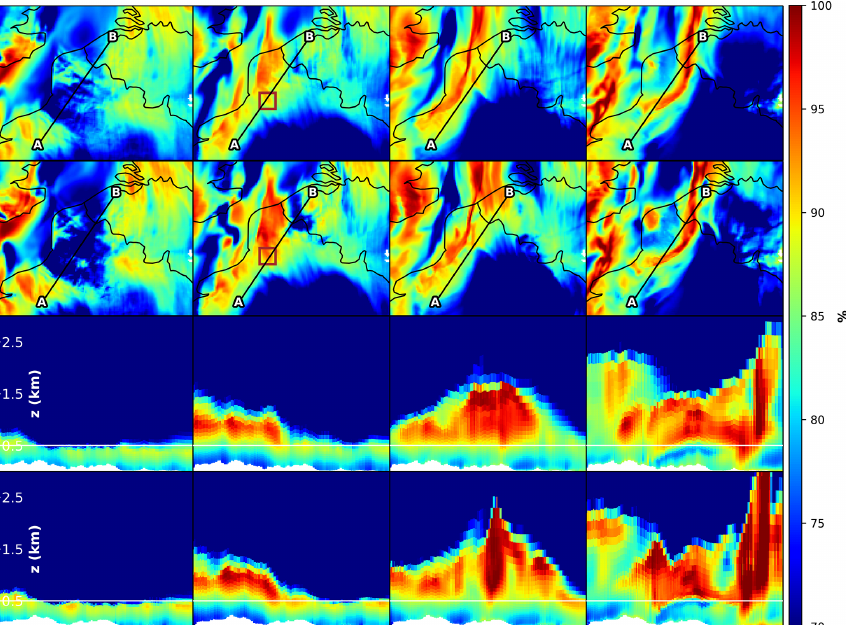
Figure 21. Relative humidity (RH) plots (red means high RH, blue low RH) for 10 September 2011. The four columns refer to hours 12:00, 14:00, 16:00, and 18:00UTC. The first row (cy40REF) and second row (cy40NEW) show a map of RH at approximately 500m height that covers parts of Belgium and northwest France, as well as a black line. Along this line, a vertical atmospheric cross section for the lowest 3km is shown in the third (cy40REF) and fourth (cy40NEW) rows. In the cross sections, the boundary layer can be recognised by relatively high RH values. The white line at 500m in the cross sections shows the height for which the RH is plotted in the two upper rows. The rectangle in the second column of the two upper rows indicates the area used to produce the skewed T profile in Fig. 22.